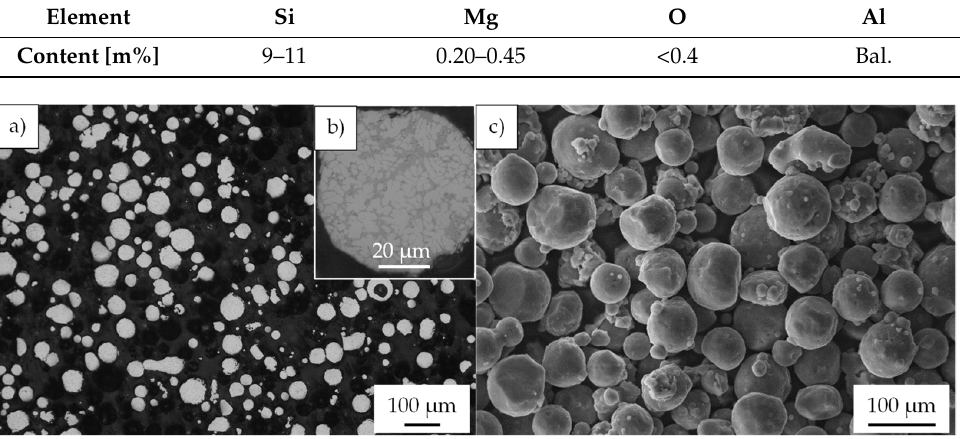
Figure 1. Gas-atomized Al-alloy powder AlSi10Mg0.4: ( a , b ) light microscopic images of the cross- section of the powder; ( c ) SE-SEM image.